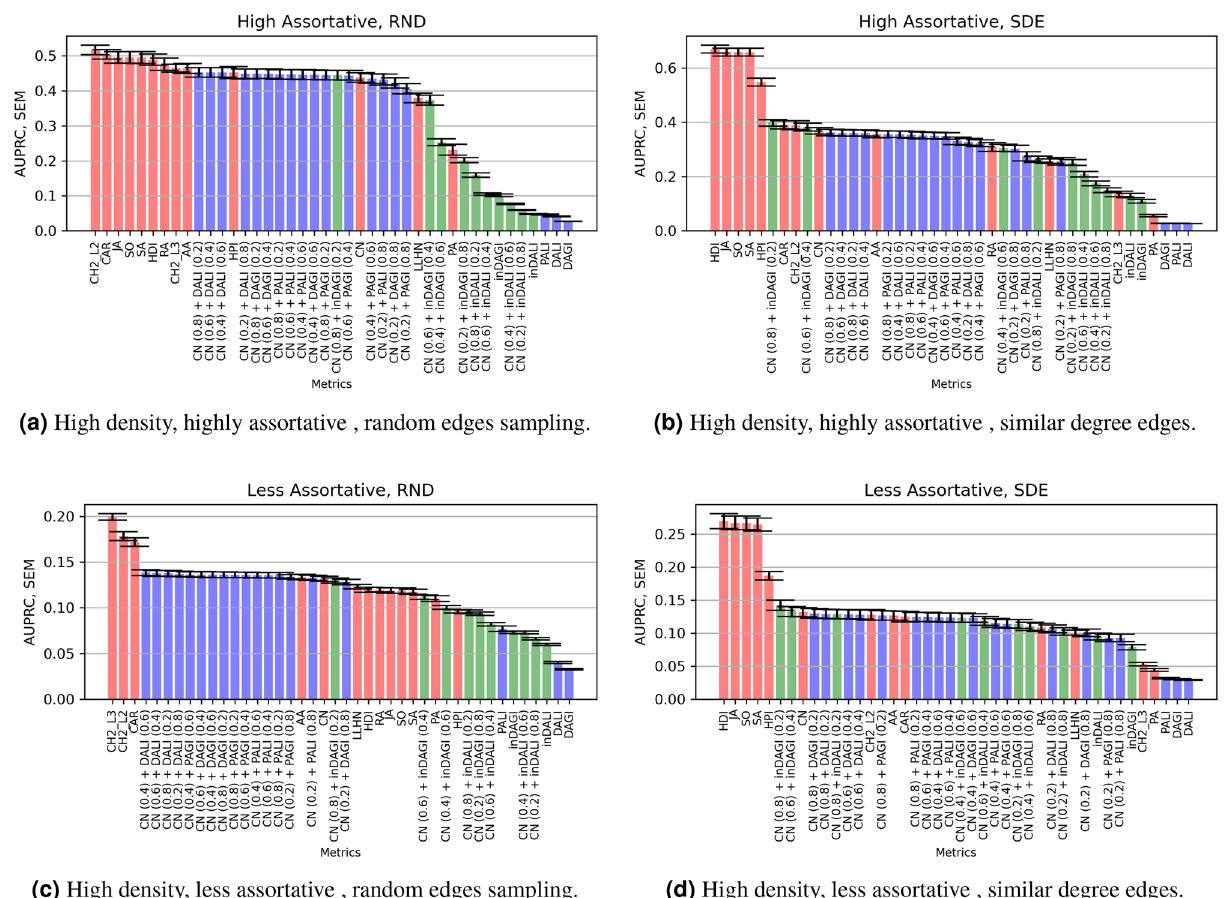
Figure 5. Performance of the LP models (i.e., the average AUPRC values) implemented on the high density, assortative synthetic network sets of size (100, 200, 250, 500, and 1000 nodes), 500 networks each. See Table 2 for high and less assortativity coefficient r ranges, respectively. Red bars refer to standard LP models, blue bars refer to dissimilarity-based metrics along with their extensions and green bars refer to similarity-based metrics along with their